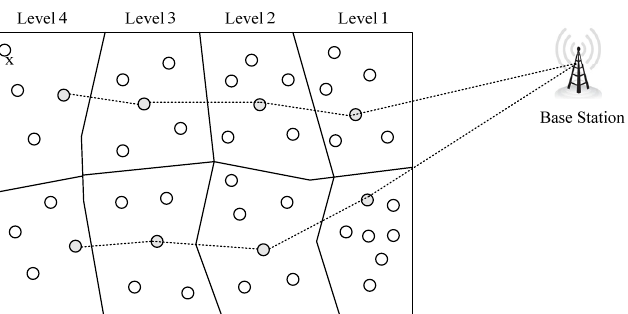
Figure 1. The network model